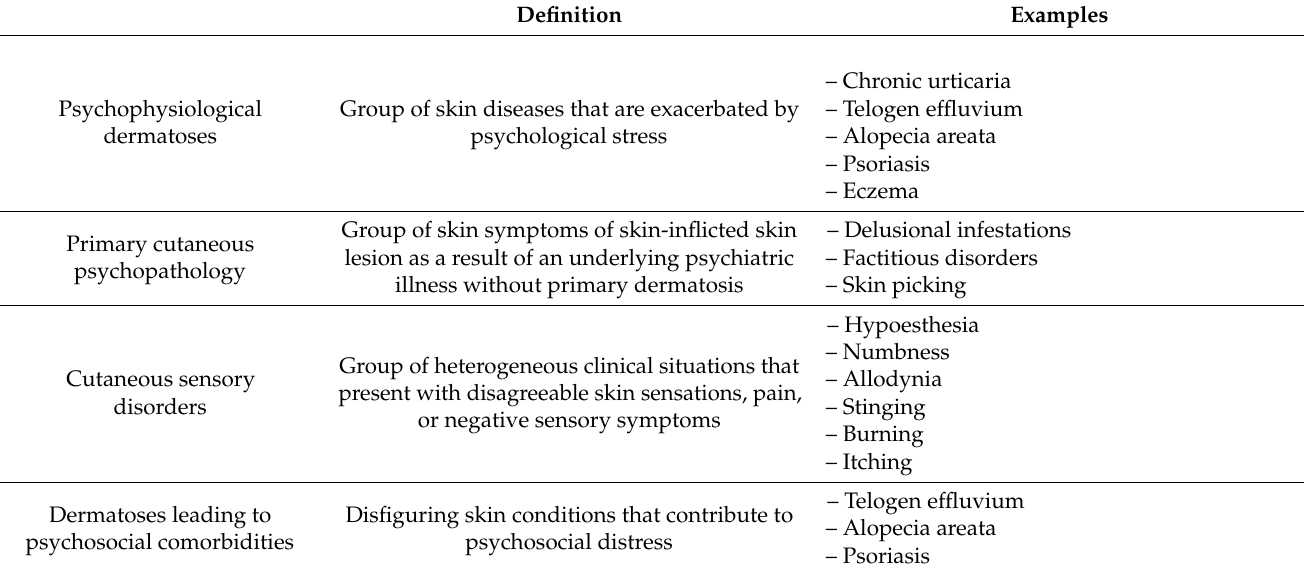
Table 4. Classification of Psychodermatological